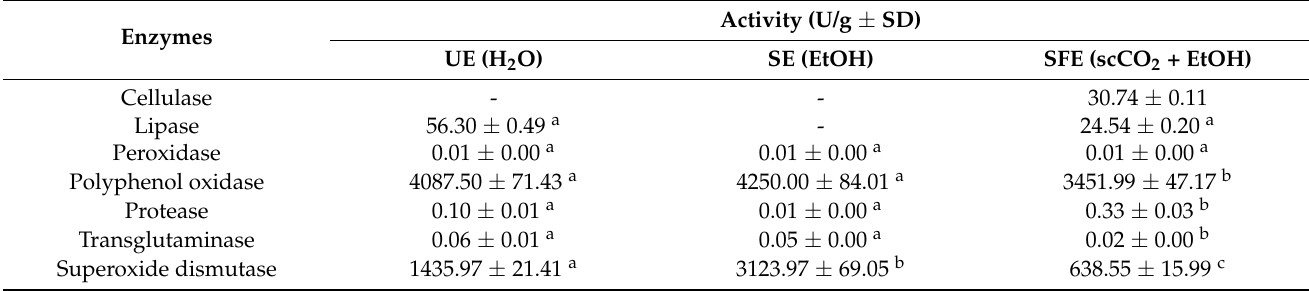
Table 3. Enzyme activities of AS extracts obtained by ultrasonic extraction (UE; solvent H 2 O), Soxhlet extraction (SE; solvent EtOH), and supercritical fluid extraction (SFE; solvent scCO 2 , co-solvent